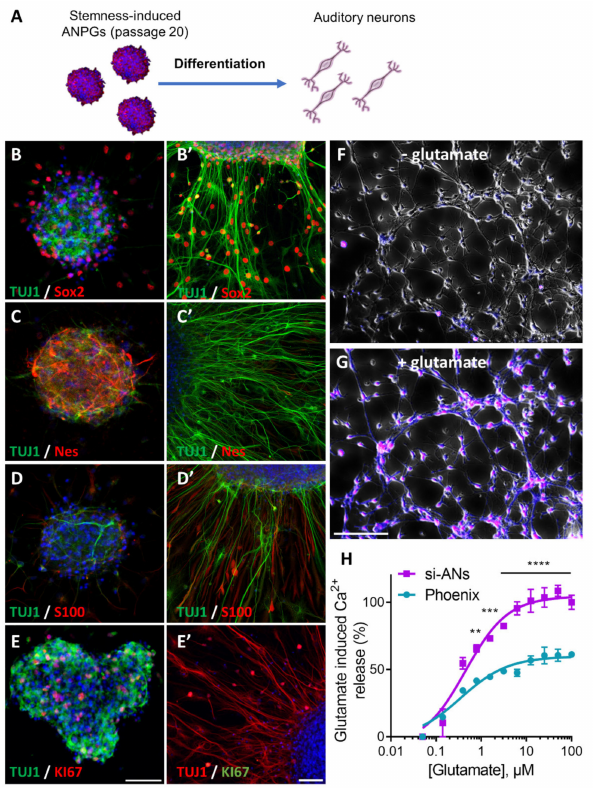
Figure 6. Phenotypical characterization of stemness induced Auditory Neurons (si-ANs) at pas- sage 20 . ( A ) C57Bl/6 ANPG, were treated with WNT agonist (CHIR99021; 3 µ M) or TGF β smad an- tagonist (dual SMAD inhibitors; LDN193189 0.5 µ M, SB431542 10 µ M) aiming at replicating phoenix ANPG stemness phenotype. After reprogramming and an expansion of 20 passages, stemness- induced ANPGs were differentiated on Matrigel coating following removal of mitogenic factors. BDNF (10 ng/mL), NT-3 (50 ng/mL) and LIF (10 ng/mL) were added during the 7 days of dif-